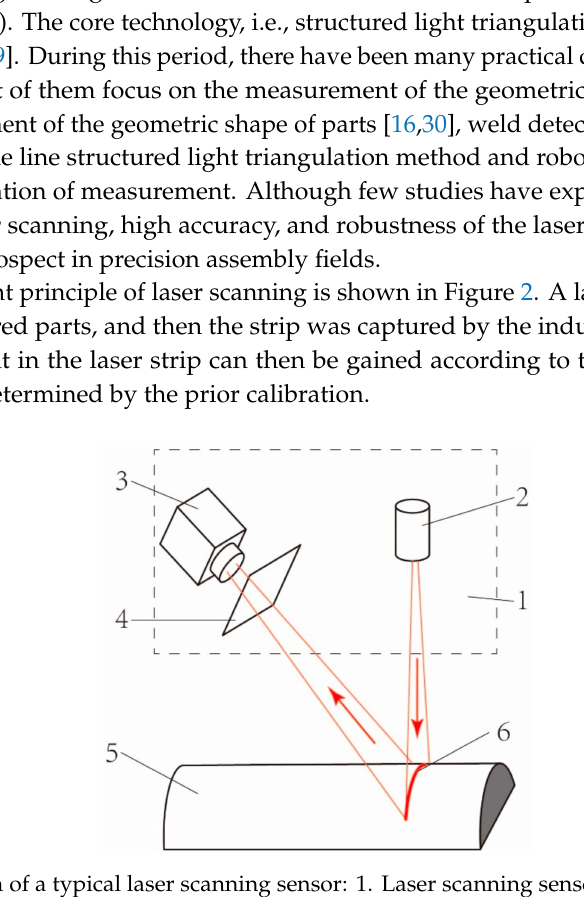
Figure 2. Diagram of a typical laser scanning sensor: 1. Laser scanning sensor; 2. Laser projector; 3. Camera; 4. Imaging Plane; 5. Part to be measured; 6. Laser